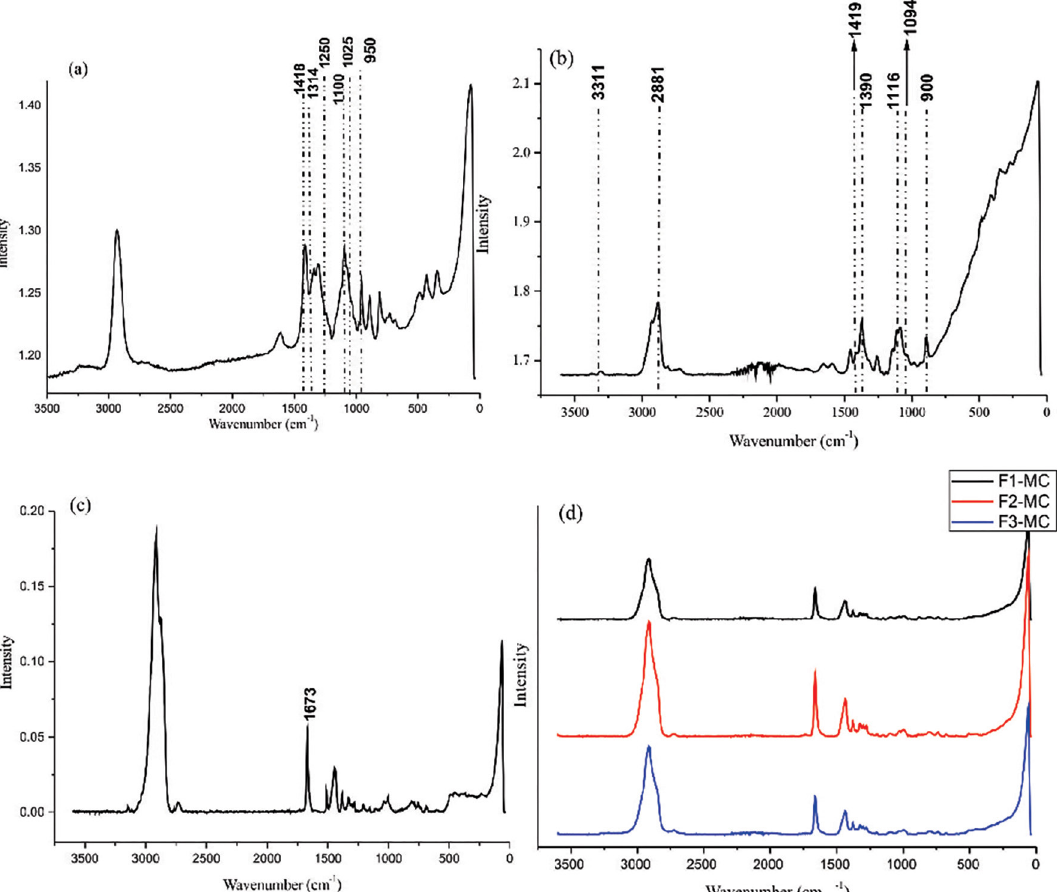
FIGURE 6 - FT-Raman of alginate (a), low molecular weight chitosan (b), of the FHPp (c) and FHPp-loaded microcapsules